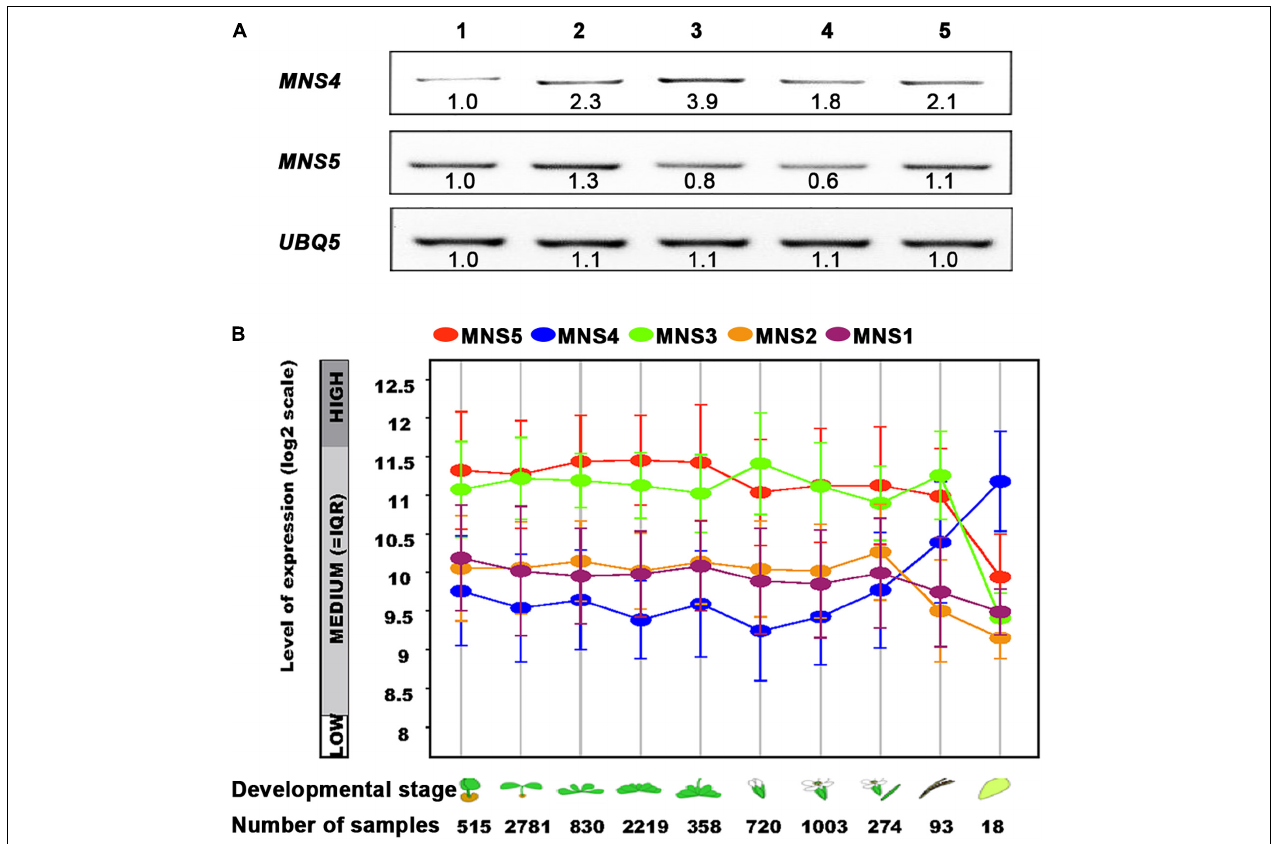
FIGURE 7 | The expression levels of MNS5 and MNS4 in different developmental stages. (A) The transcripts of MNS4 and MNS5 were performed using RT-PCR analysis in WT Ws-2. UBQ5 was a control. 1: 2-weeks-old seedlings, 2: 50-day-old rosette leaves, 3: 50-day-old flowers, 4: 50-day-old siliques, 5: 68-day-old rosette leaves. (B) The transcripts comparison of MNS1 - MNS5 was plotted as a line graph during the 10 developmental stages from dataset AT_AFFY_ATH1-0 (https://www.genevestigator.com/gv/plant.jsp). The 10 developmental stages: Germinated, young seedling, rosette, developed rosette, bolting and young,